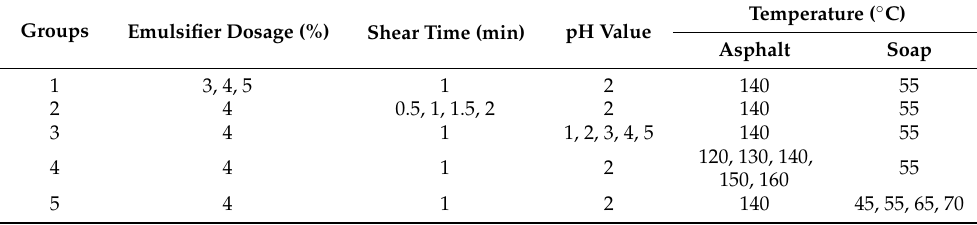
Table 2. Preparation parameters of asphalt